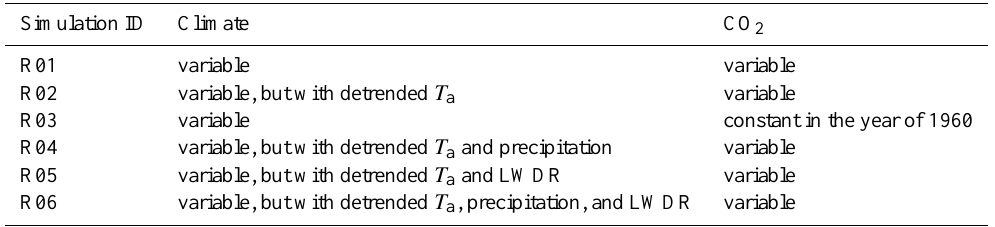
Table 2. Description of simulations used in this study.